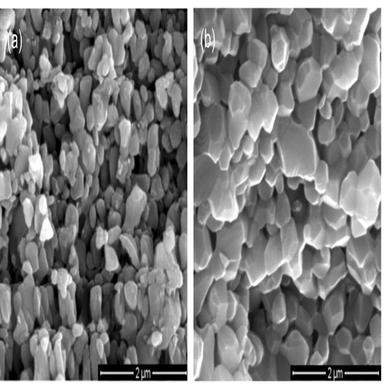
SEM images of the fractured FDM α-alumina surfaces; (a) sintered at 1200 ◦C, (b) sintered at 1400 ◦C.